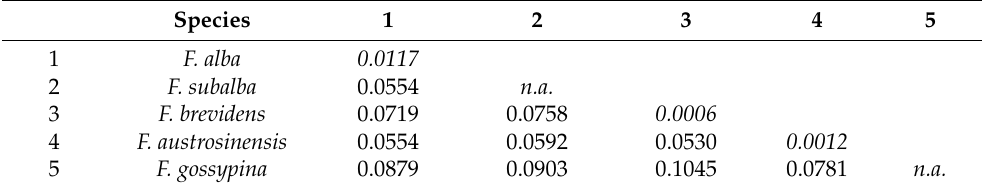
Table 2. Genetic distances of ITS sequences between and within species of Fibrodontia .